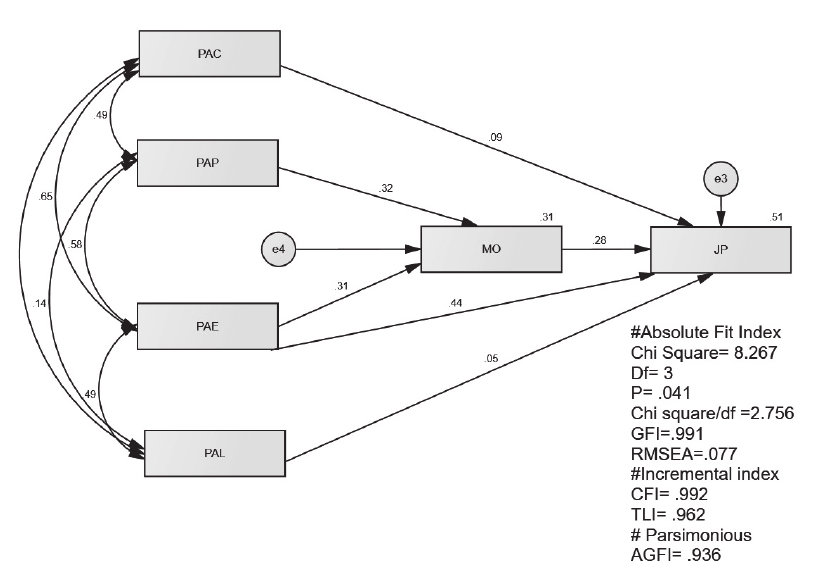
Fig. 2. The summary of the results of testing the hypotheses